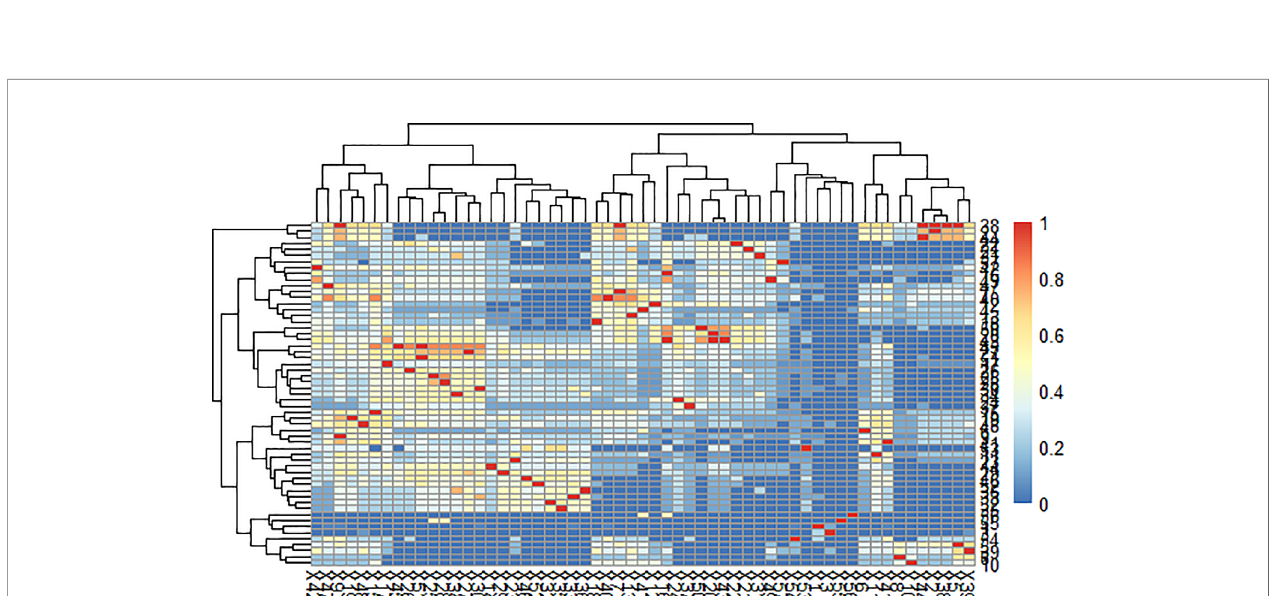
FIGURE 3 | Af fi nity diagram of the mass spectra of glycerides with software-based group classi fi